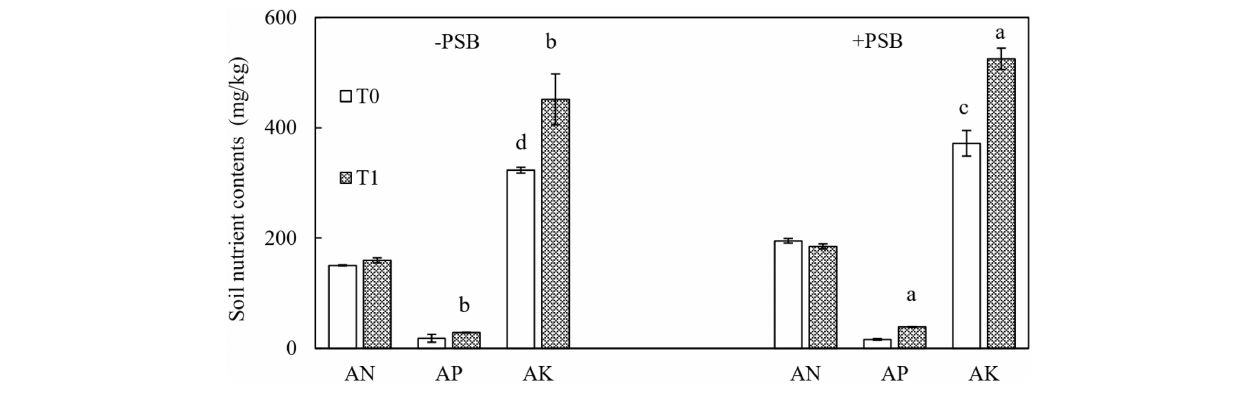
FIGURE 3 | Effects of rock phosphate (RP) and phosphate-solubilizing bacteria (PSB) on soil available nitrogen (AN), available phosphorus (AP), and available potassium (AK) contents (mg/kg). Treatments: T0, without RP; T1, with RP; − PSB, without PSB; +PSB, with PSB. Values are the means of three replicates. Error bars represent ± standard deviation. Values sharing a common letter within the column are not significant at P < 0 . 05.